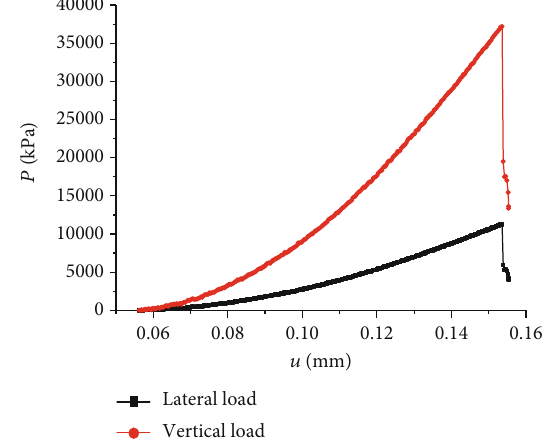
Figure 11: Displacement-center point tension stress and load point vertical stress.